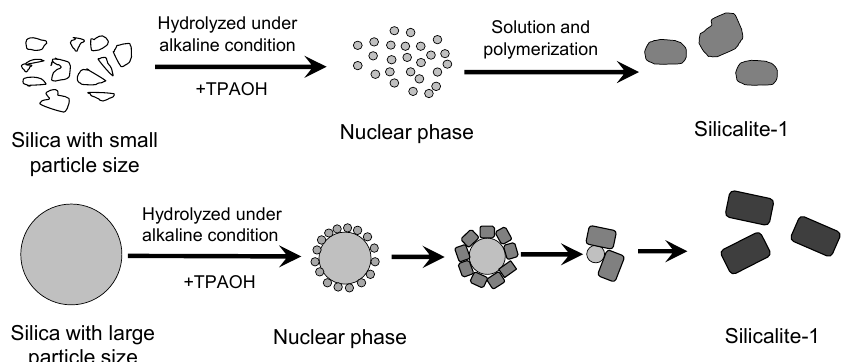
Figure 8. Schematic diagram of silicalite-1 growth using silica sources with different particle sizes during the synthesis process.